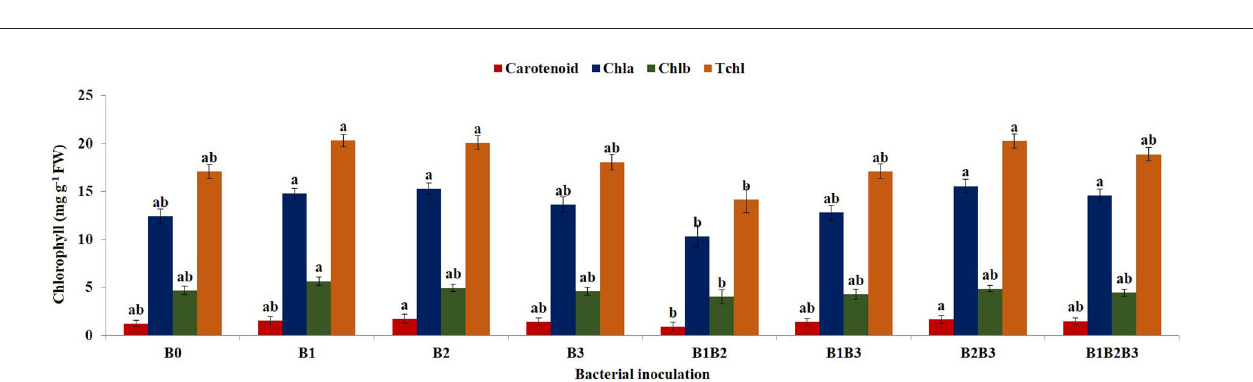
FIGURE7 Effect of bacterial inoculation on chlorophyll content of maize plants. Values are presented as means ± standard error ( n = 24). Means with different letters are significantly different from each other according to Tukey’s Studentized Range test ( p ≤ 0.05). B 0 , un-inoculated control; B 1 , Pseudomonas sp. MRBP4; B 2 , Pseudomonas sp. MRBP13; B 3 , Bacillus sp. MRBP10; B 1 B 2 , Pseudomonas sp. MRBP4 + Pseudomonas sp. MRBP13; B 1 B 3 , Pseudomonas sp. MRBP4 + Bacillus sp. MRBP10; B 2 B 3 , Bacillus sp. MRBP10 + Pseudomonas sp. MRBP13; B 1 B 2 B 3 , Pseudomonas sp. MRBP4 + Pseudomonas sp. MRBP13 + Bacillus sp.